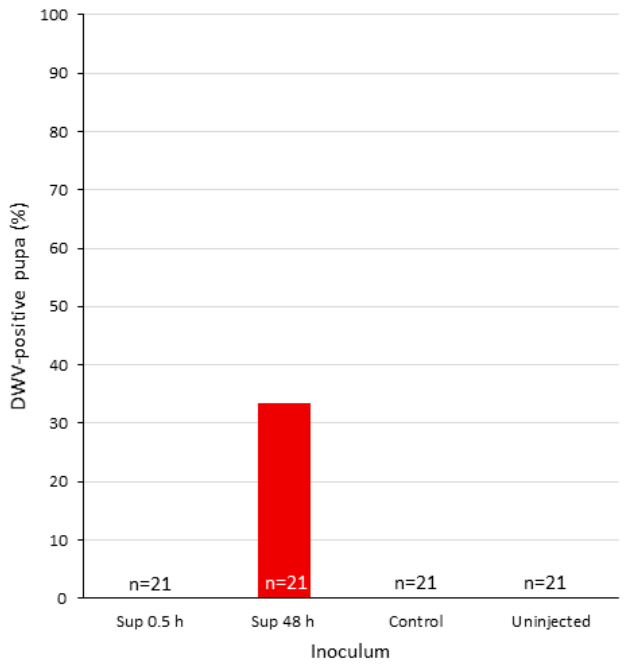
Figure 5. DWV prevalence of injected pupae. X -axis, individual pupae treated as follows: Injected with DWV-P1 at 0.5 and 48 h (Sup. 0.5 and 48 h, respectively) supernatant from mock-infected cells (control) or uninjected (see Materials and Methods, Section 2.5).